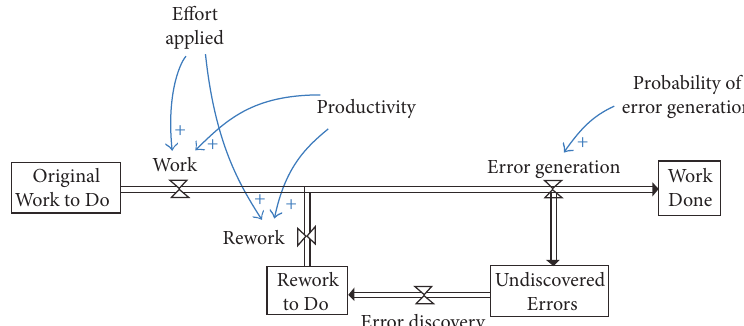
Figure 1: Rework cycle 1/3: the basic